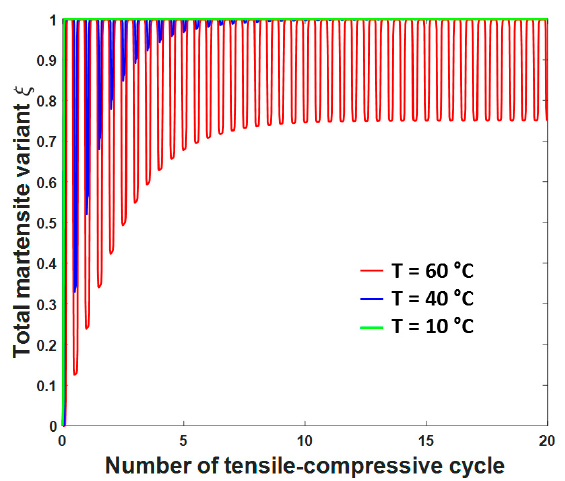
ξ during tensile-compressive cycling under